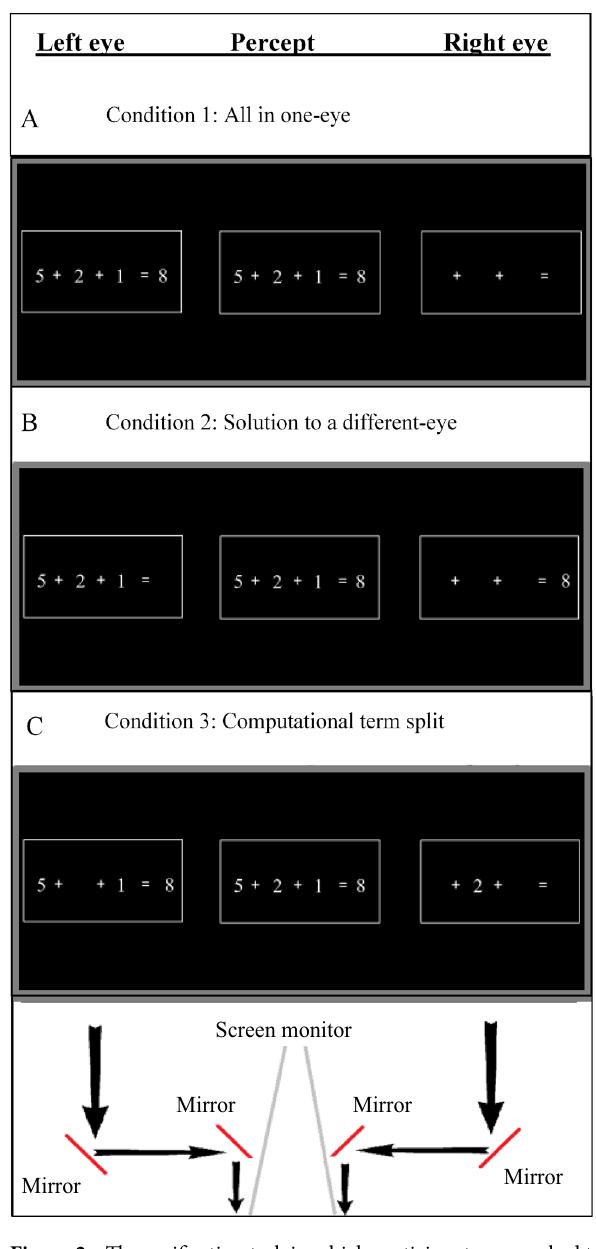
Figure 2. The verification task in which participants were asked to solve equations (by subtraction and addition) composed of an arithmetic problem of three numbers and a solution (e.g., 5 + 2 + 1 = 8). The three numbers and the equation’s solution were either presented: ( A ) All in one-eye or ( B ) Solution to a different-eye: arithmetic problem to one eye and the solution to the other eye or ( C ) Computational term split: one of the numbers to one eye and the other two numbers and the solution to the other